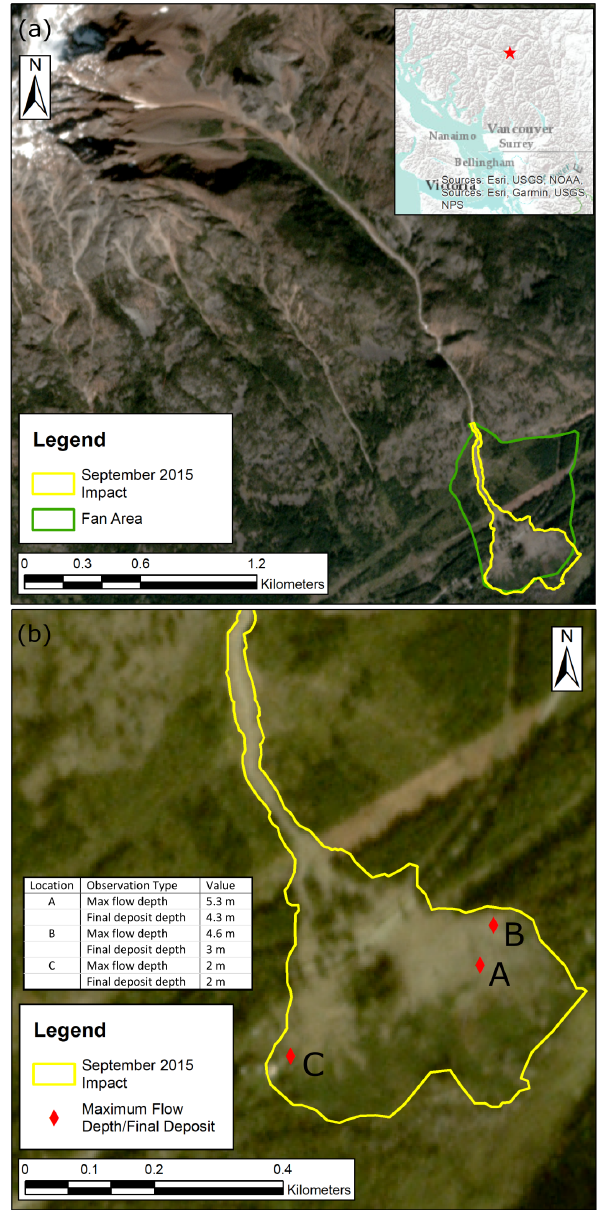
Figure 13. Neff Creek 2015 impacts. Background imagery from Planet Inc.